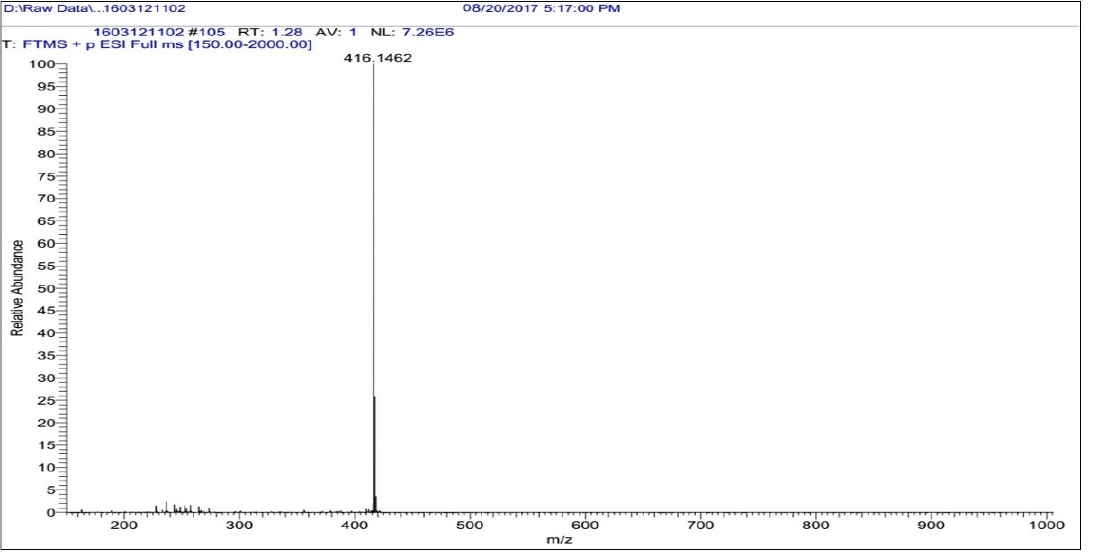
Figure 7. Mass Spectroscopic analysis the purified compound from the extracts of Leucas indica flow- ers.